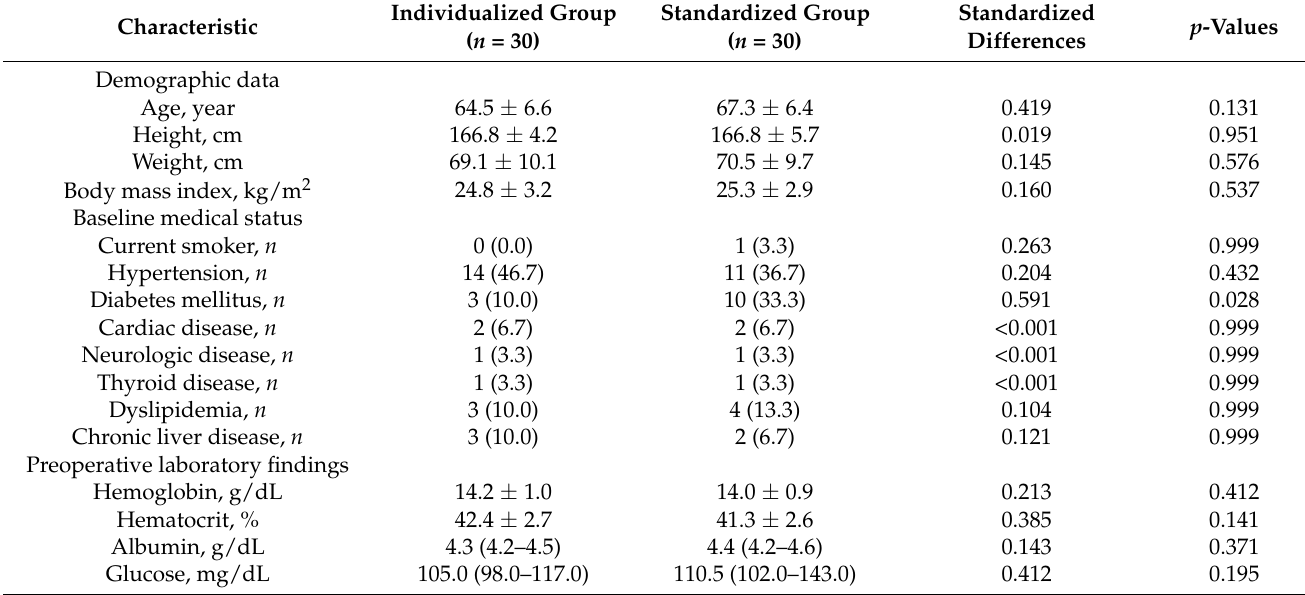
Figure 3. Consolidated Standards of Reporting Trials (CONSORT) flowchart. Table 1. Comparison of intraoperative anesthesia-related variables between the individualized and standardized groups.